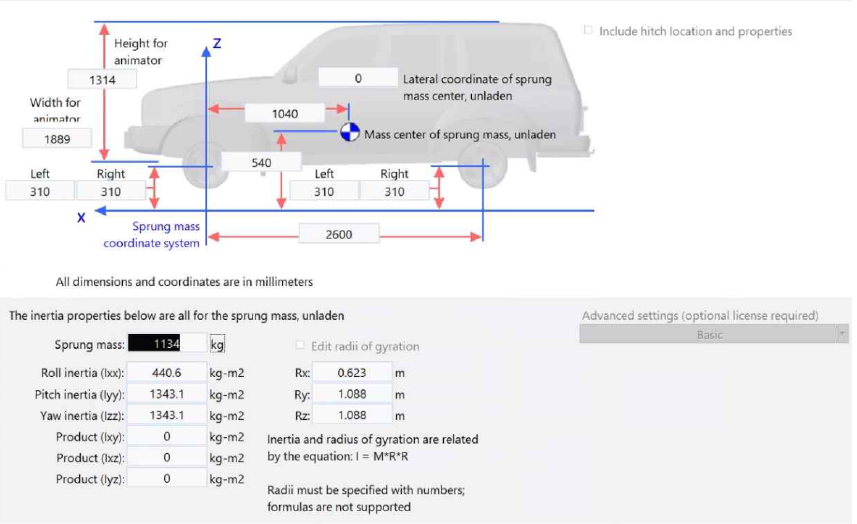
Figure 18. Simulation with varying vehicle weights: by applying different vehicle weights, the inertia and radius of gyration were